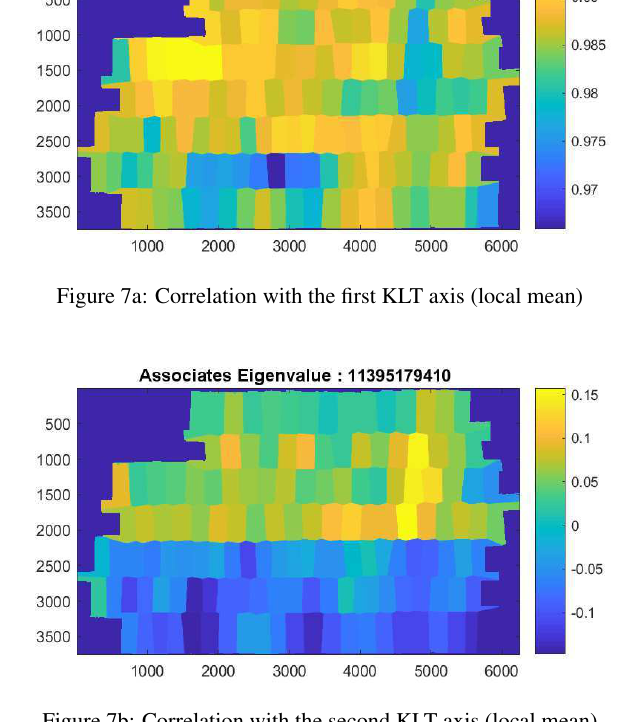
Figure 7b: Correlation with the second KLT axis (local mean)